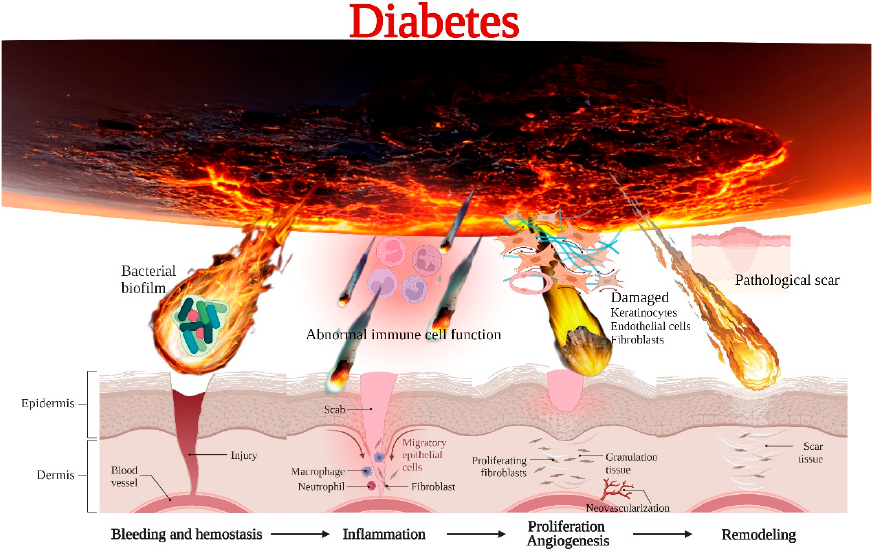
Figure 2. The molecular and cellular mechanisms in delayed diabetic skin wound